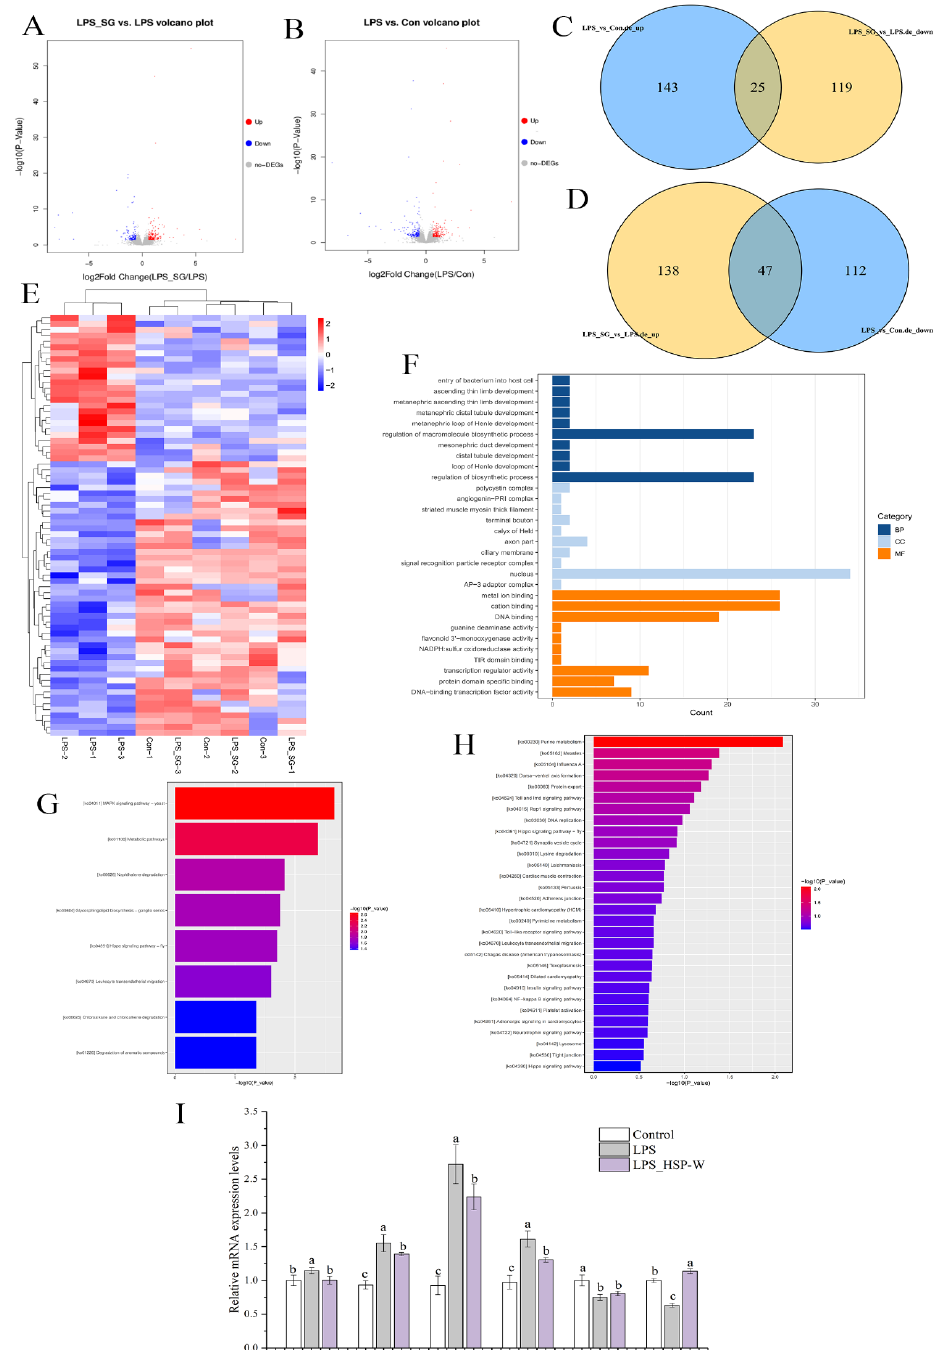
Figure 4. Transcriptomics analysis of effects of HSP-W on LPS-induced intestinal barrier injury. The DEGs are represented as a volcano figure. ( A ) LPS_SG vs. LPS, ( B ) LPS vs. Con, ( C , D ) Venn diagrams revealing DEGs regulated by HSP-W treatment, ( E ) heatmap revealing DEGs regulated by HSP-W treatment, ( F ) GO enrichment of the overlapping DEGs, KEGG enrichment of DEGs: ( G ) comparing the LPS_SG and LPS groups, ( H ) those reversed by HSP-W pre-incubation, ( I ) relative mRNA expression level of selected genes for verification. Different letters represented the significant difference at p < 0.05.